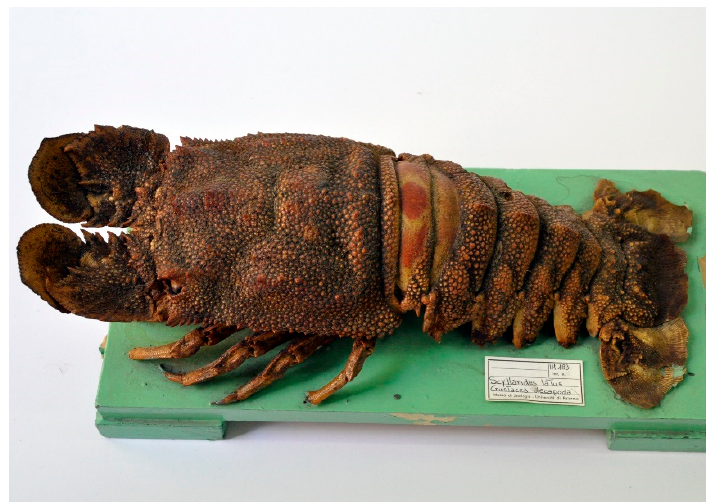
Figure 2. Scyllarides latus